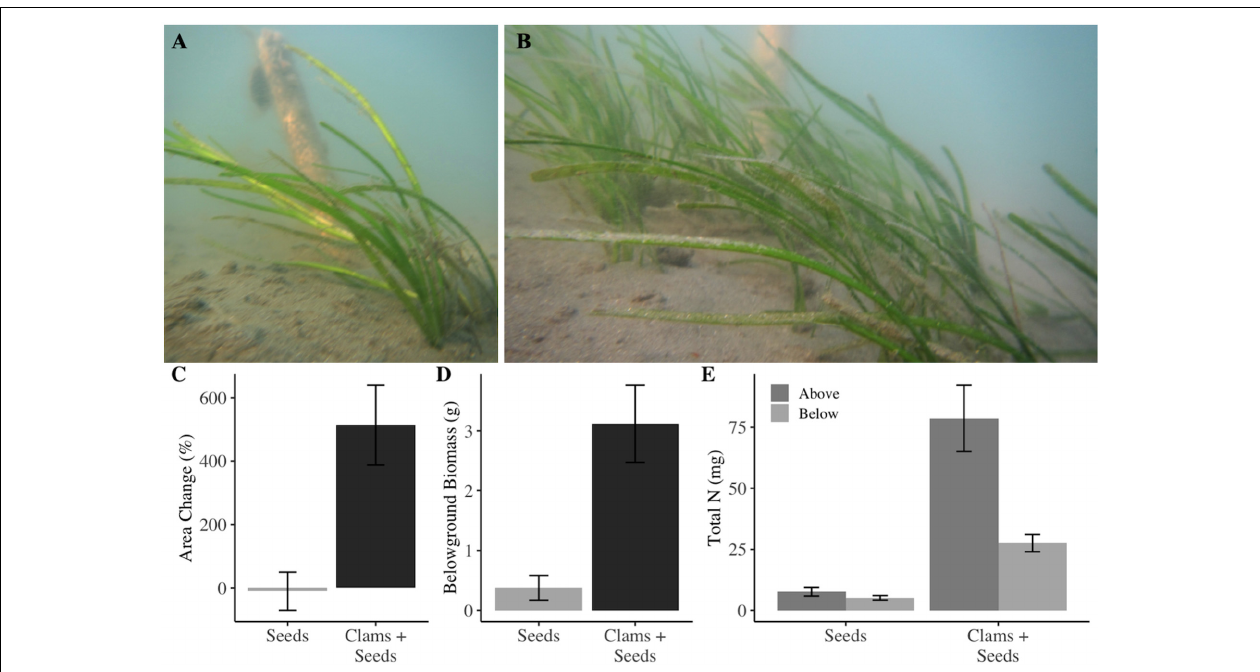
FIGURE 3 | Demonstrative (A) seed only and (B) seeds and clams plots in May 2018 at experiment end. Seagrass seeds sown with infaunal clams exhibited (C) over 500% increase in in patch area relative to initial patch size ( p = 0.023), and (D) seven times more belowground biomass, p = 0.04, and significantly greater (E) total nitrogen above- and belowground ( p < 0.001, p < 0.001). Error bars represent one standard